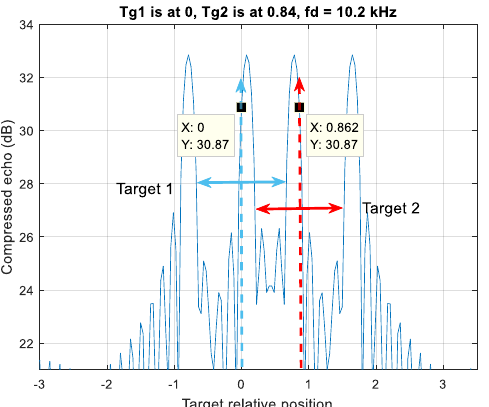
Figure 6. Case 2, an up-down chirp LFM waveform resolves four detection peaks by two moving targets. The detection pair of each target has one side crossover.